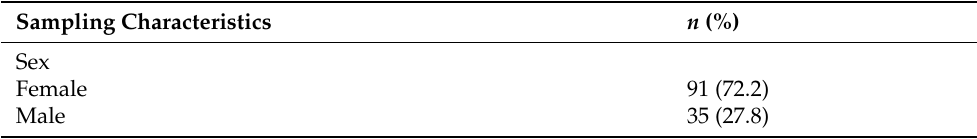
Table 1. Sampling characteristics ( n =